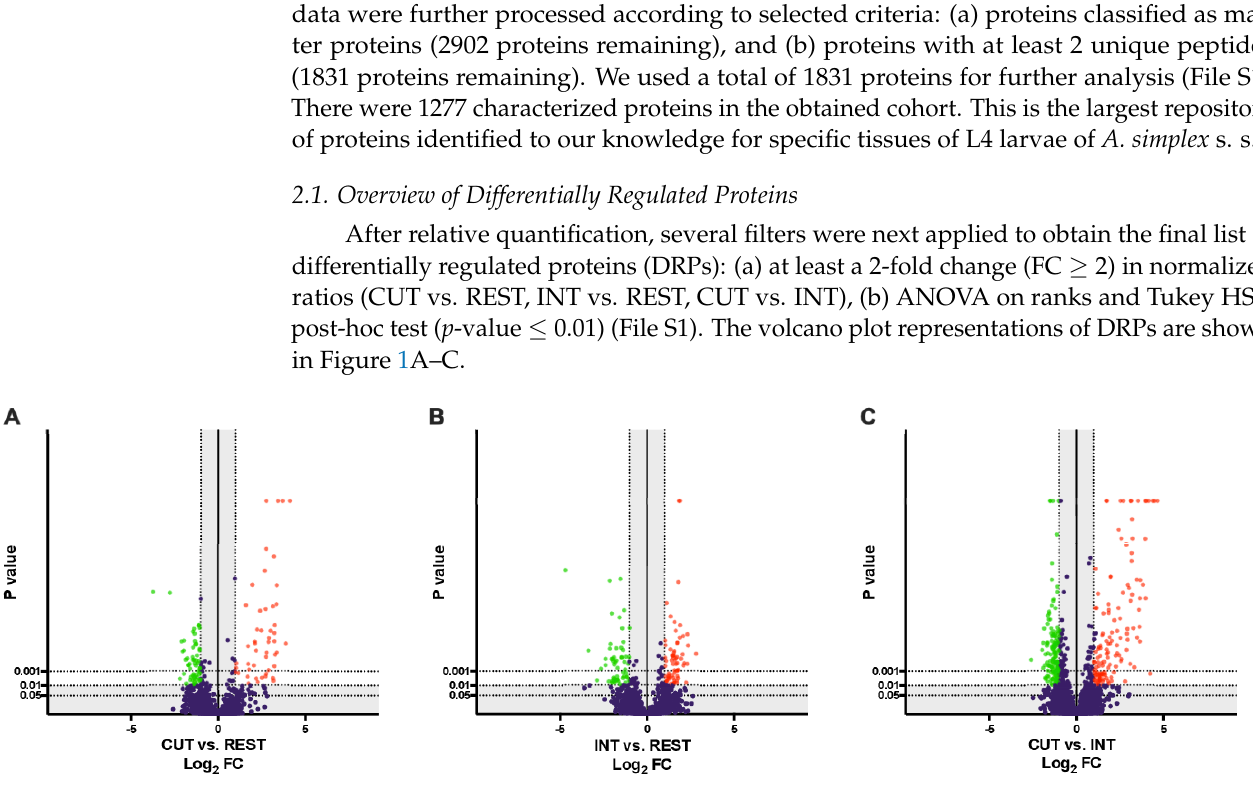
Figure 1. Volcano-plot representations of tissue-specific proteome of the L4 developmental stage of Anisakis simplex s. s. The following comparisons between the groups were visualized: ( A ) cuticle vs. the rest of the body of the L4 stage larvae, ( B ) intestine vs. the rest of the body of the L4 stage larvae, and ( C ) cuticle vs. intestine (FC ≥ 2, p -value ≤ 0.01). The detailed list of DRPs in each of the compared groups is presented in File